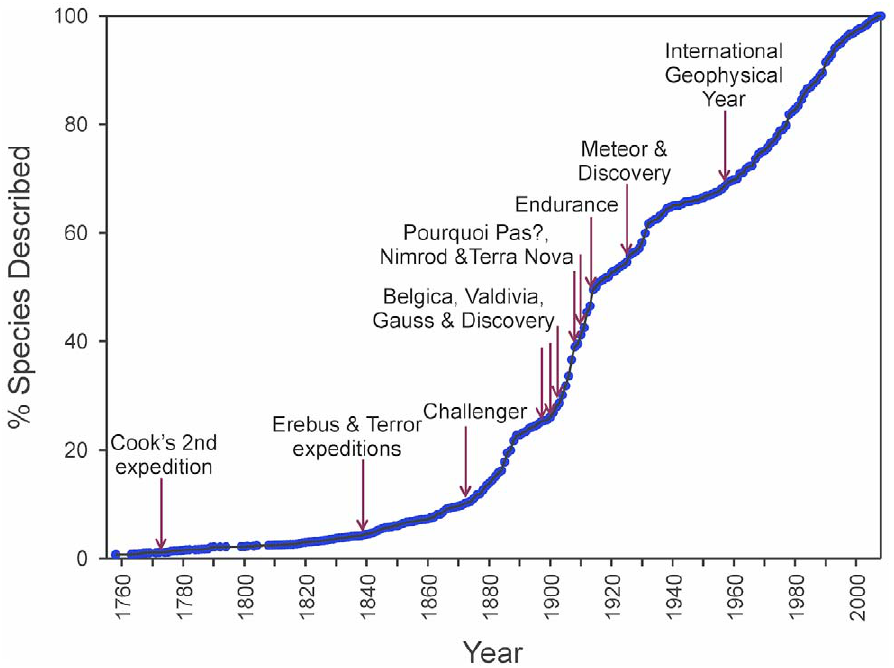
Figure 5. The rate of species description and biological research in the Southern Ocean through time. The history of Antarctic marine biological research (red arrows) plotted with the increase of new species descriptions for the region over time.